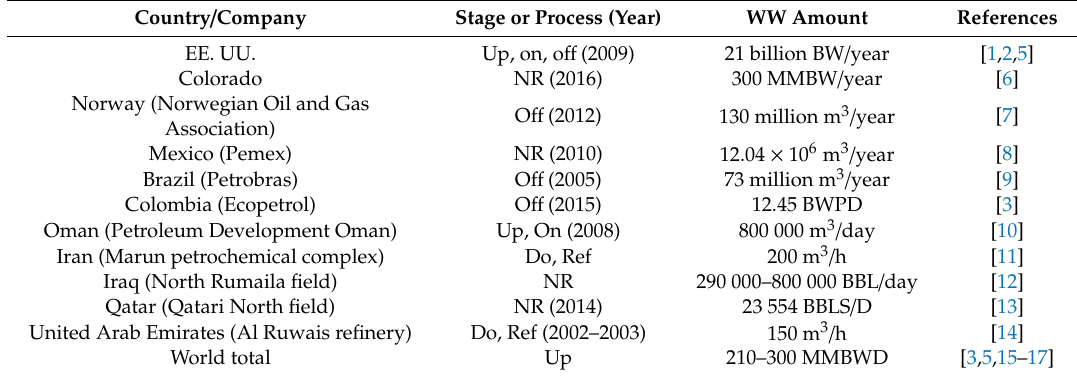
Table 1. A few indicative records of the amounts of nondomestic wastewater (WW) generated by the oil